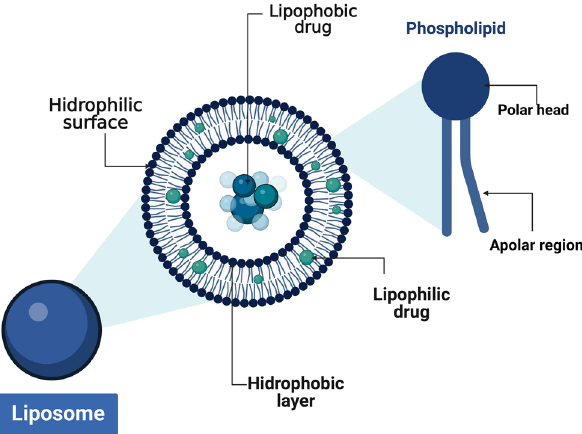
Figure 4: Liposome showing the phospholipid bilayer ( created with BioRender.com [ 98 ])